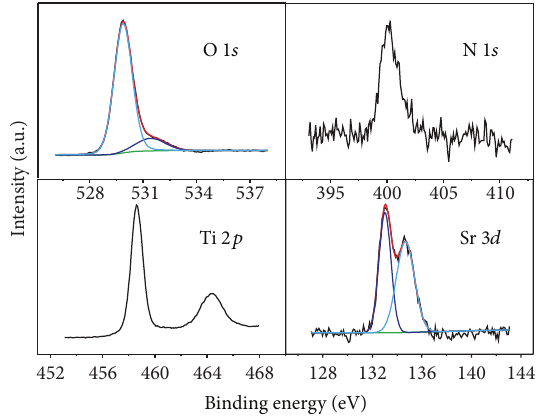
Figure 3: XPS spectra of O 1s , N 1s , Ti 2p , and Sr 3d for the SrTiO 3 /TiO 2−𝑥 N 𝑥 with the Sr/Ti ratio of